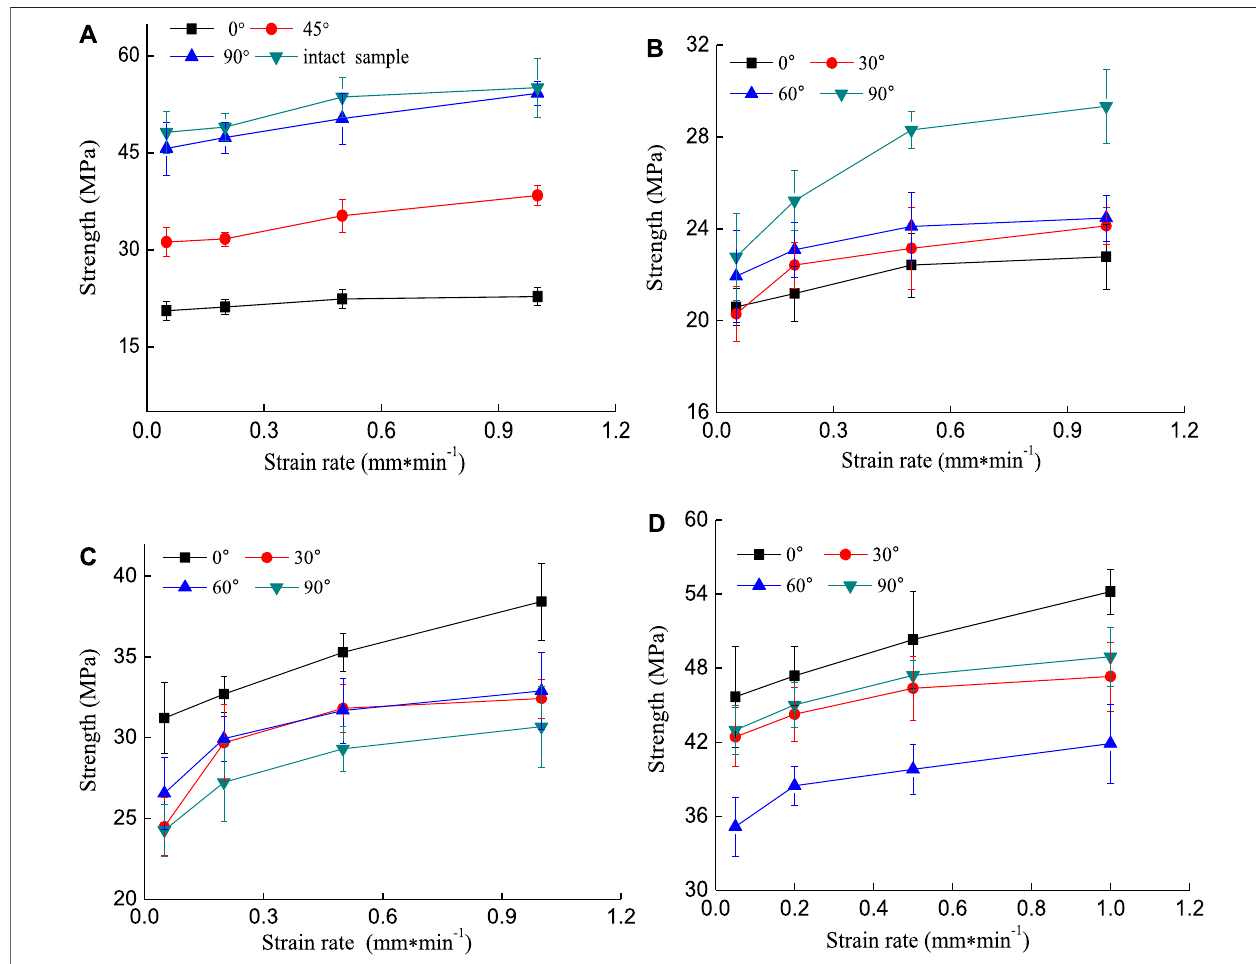
FIGURE8| Therelationshipbetweenthestrengthofcrackedsamplesandstrainrate. (A) Singlecracksampleswithdifferentinclinationangles, (B) T-shapedcrack samplescontainingthemajor fi ssureinclinationangleof0 ° , (C) T-shapedcracksamplescontainingthemajor fi ssureinclinationangleof45 ° , (D) T-shapedcracksamples containing the major fi ssure inclination angle of 90 °